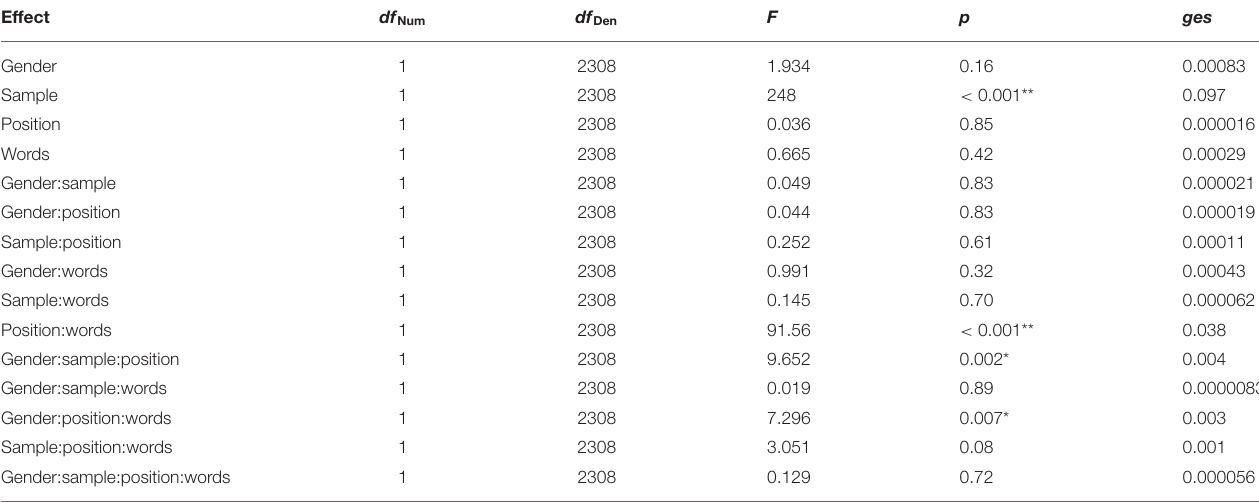
TABLE 3 | ANOVA table showing full analysis of variance of item score (substudy 3).